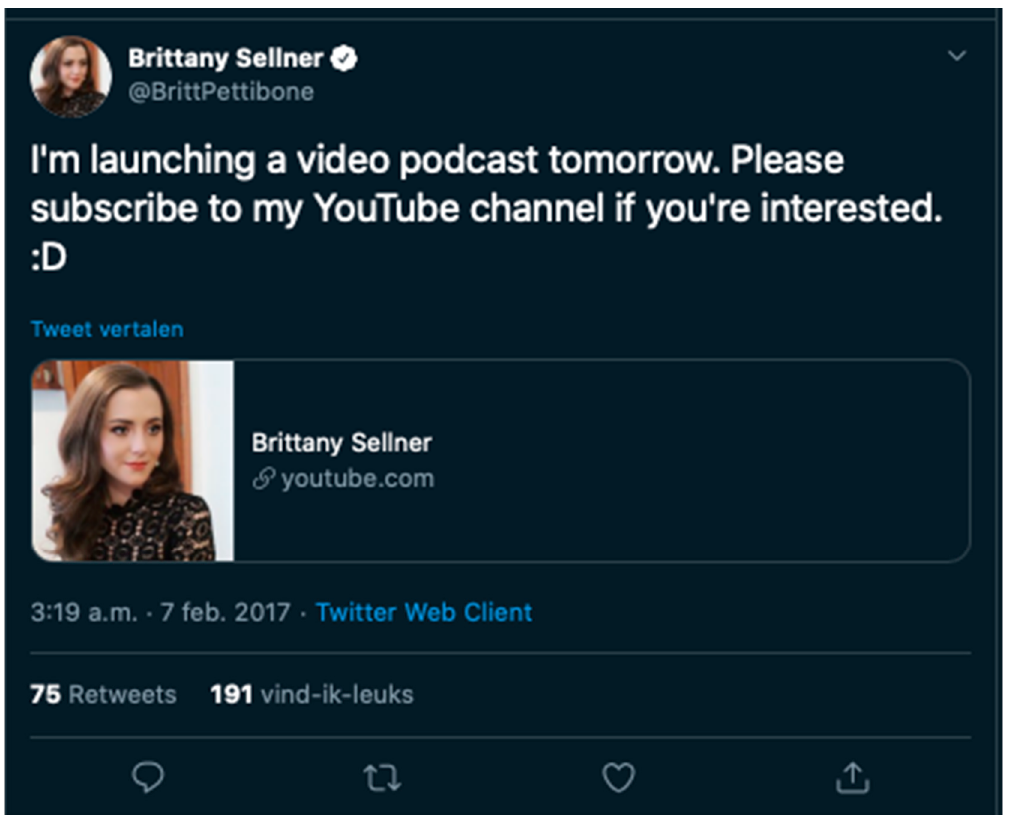
Figure 6. Using Twitter as leverage for her YouTube channel.